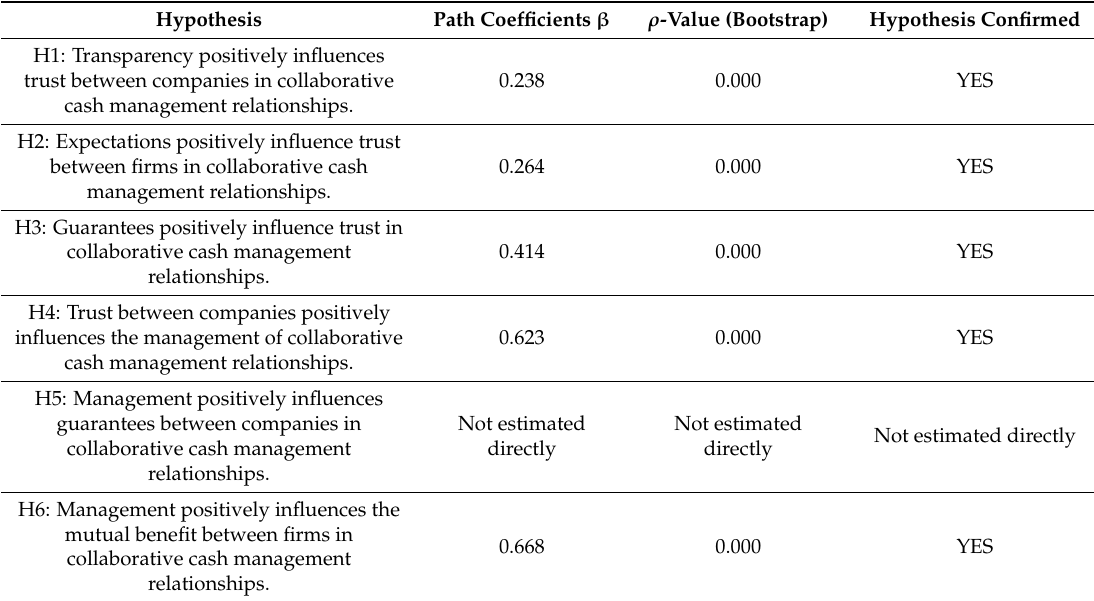
Table 3. Path analysis